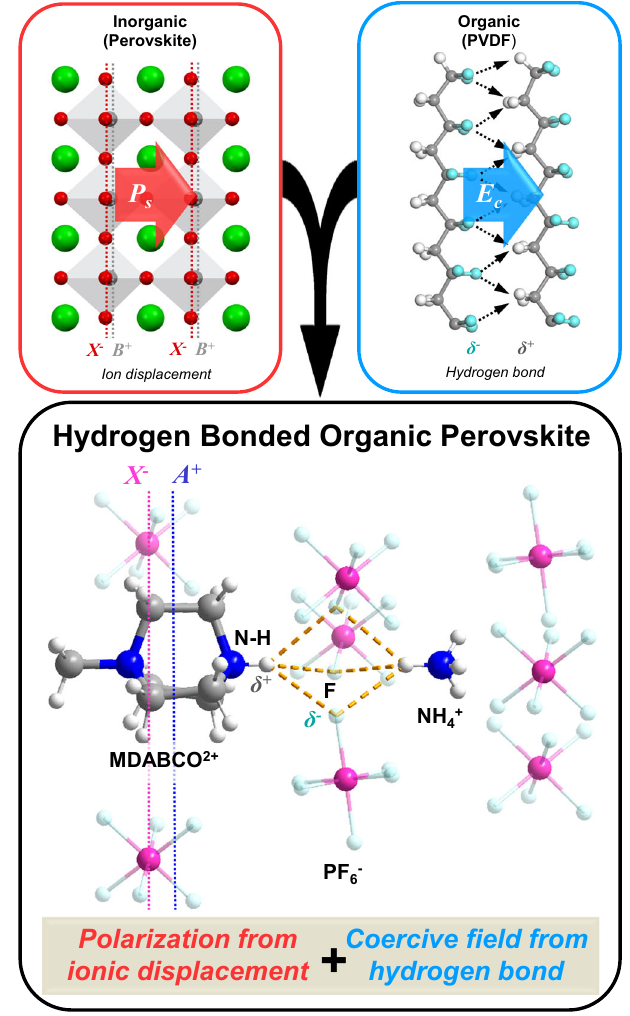
Fig. 1 Schematic of hydrogen-bond-assisted modulation of polarization and coercive fi eld for all-organic ferroelectric perovskites. Red box shows ferroelectric polarization in inorganic perovskite due to ion displacement; Blue box shows ferroelectric polarization due to hydrogen bonds in organic ferroelectric PVDF; Black box shows a combination of both ion displacement and hydrogen bonds contribute to ferroelectric polarization in organic